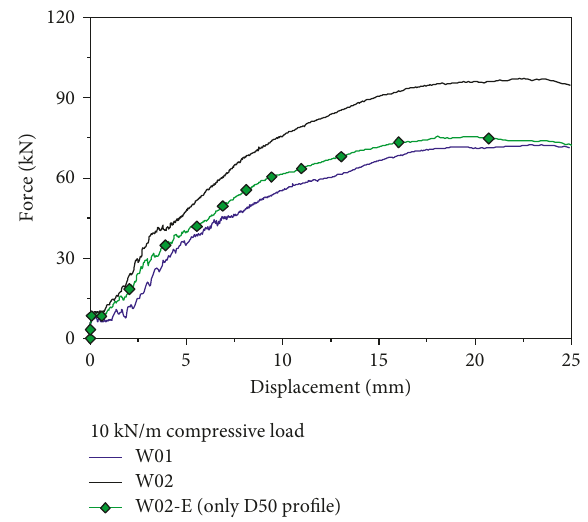
Figure 12: Load-displacement response of W01 and W02 log-haus assemblies (ABAQUS), by removing the steel dovetails